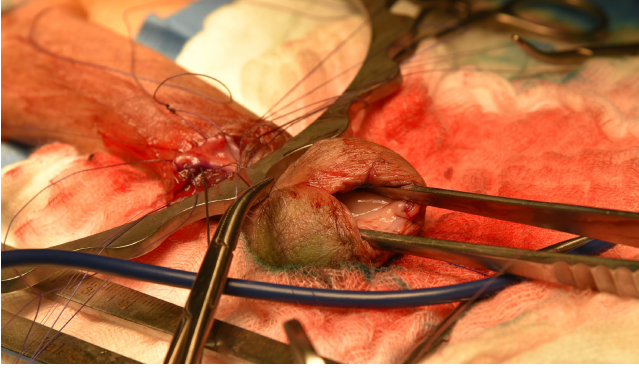
Figure 6. By introducing a forceps into the glans and then rotating it left and right, further fixation of the lateral edges and some quilting sutures can be performed much easier. Finally, complete attachment of the buccal mucosa graft at the distal part onto healthy mucosa is realized through the